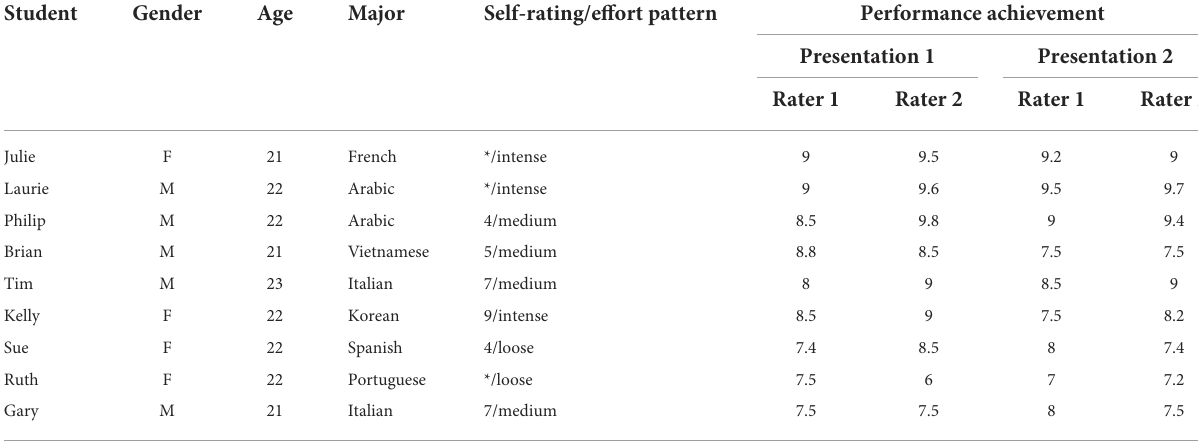
TABLE 1 Learner profiles and performances of the